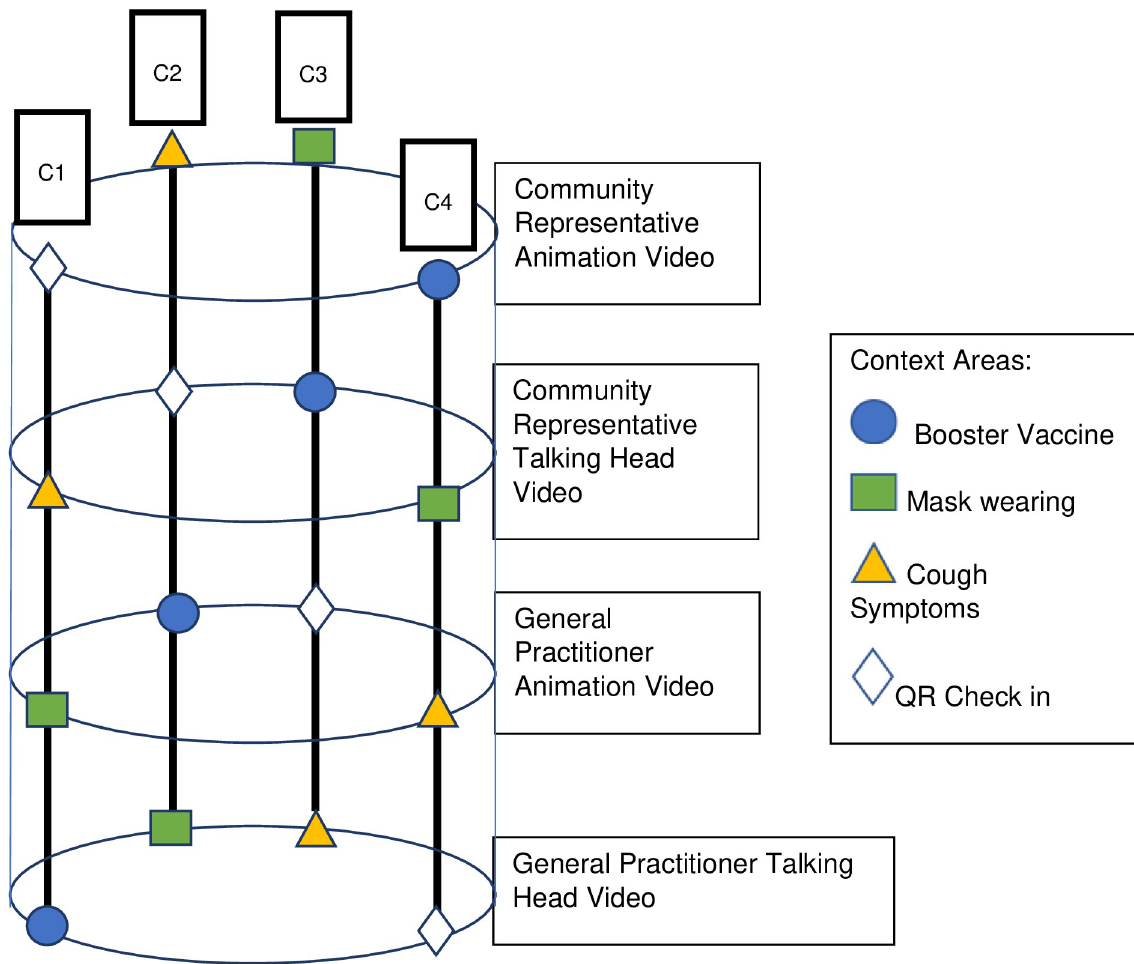
Fig 2. Visual representation of the helix randomised control trial design for Trial 1. C1 denotes combination 1, C2 denotes combination 2, C3 denotes combination 3, C4 denotes combination 4. Individual participants are exposed to the combinations of intervention level / context areas within a vertical combination